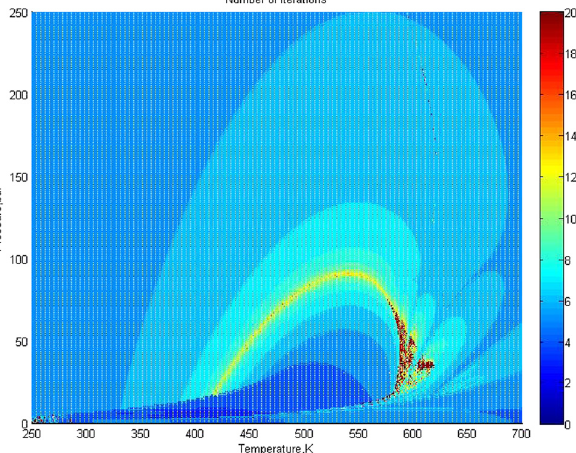
Figure 6: Number of iterations for the MY10 mixture, proposed method with type V